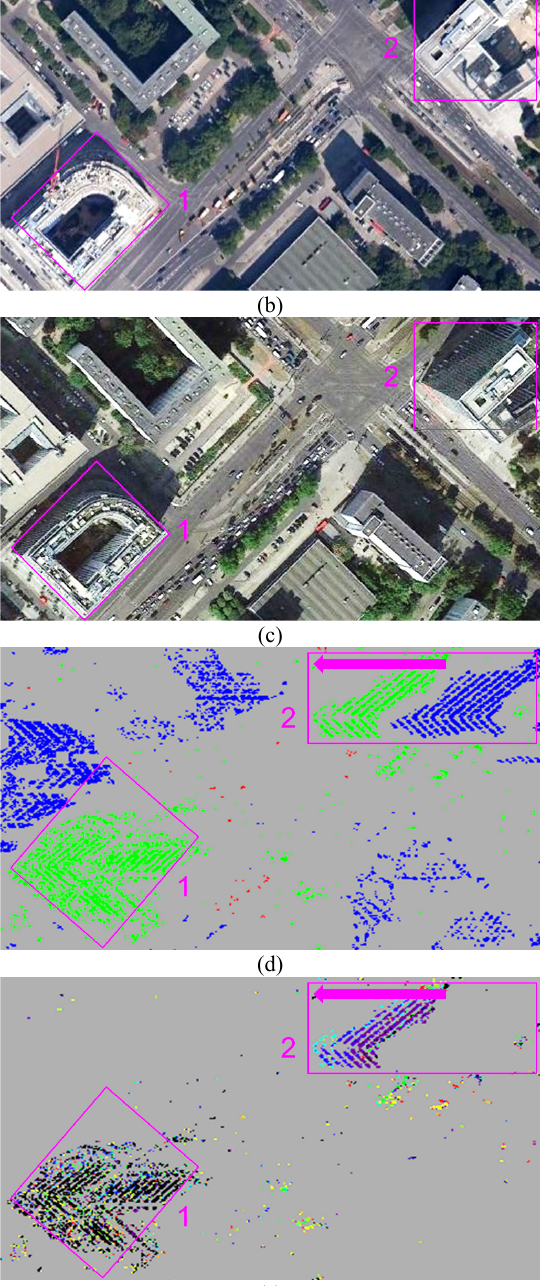
Figure 7. Construction monitoring of single high-rise buildings in patch 3 (Figure 3). Areas 1 to 2 are used for in-depth analysis. GE images were acquired on (a) September 12, 2010, (b) May 20, 2012, and (c) September 5, 2014. (d) and (e): spatiotemporal change detection result in patch 3 (Figure 4).